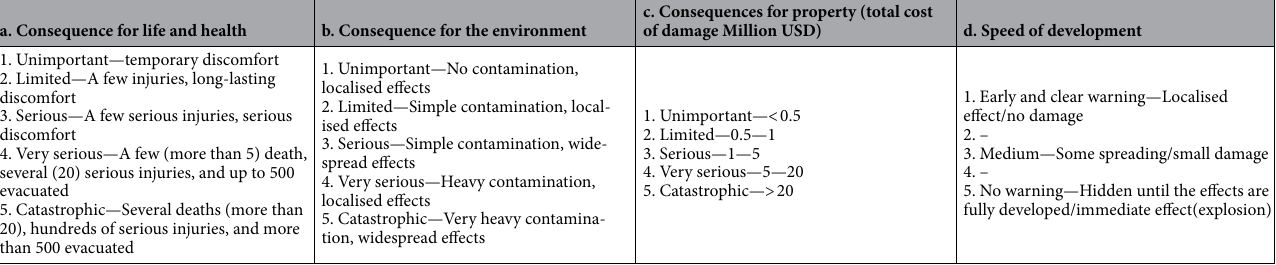
Table 1. Indicator of the consequence of a chemical factory being